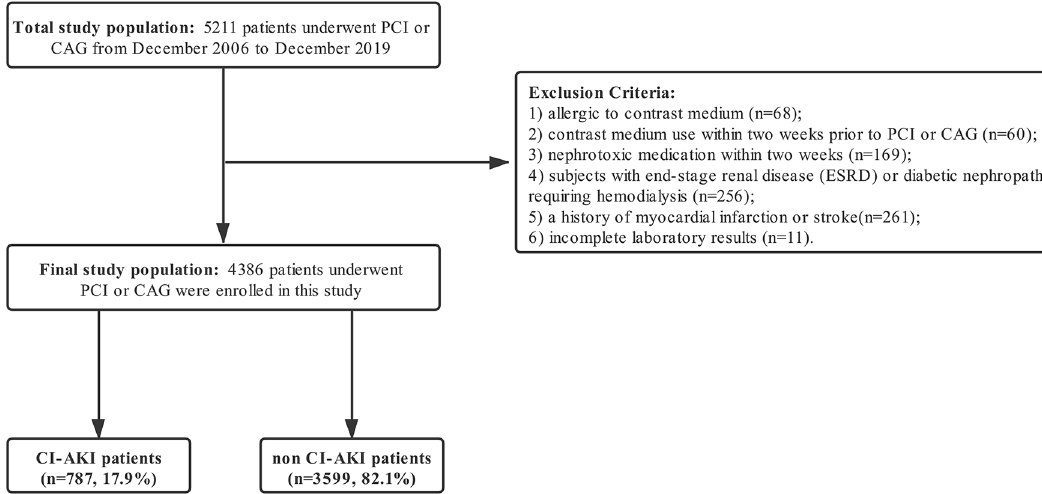
Figure 1. Flow chart of patients we enrolled in our